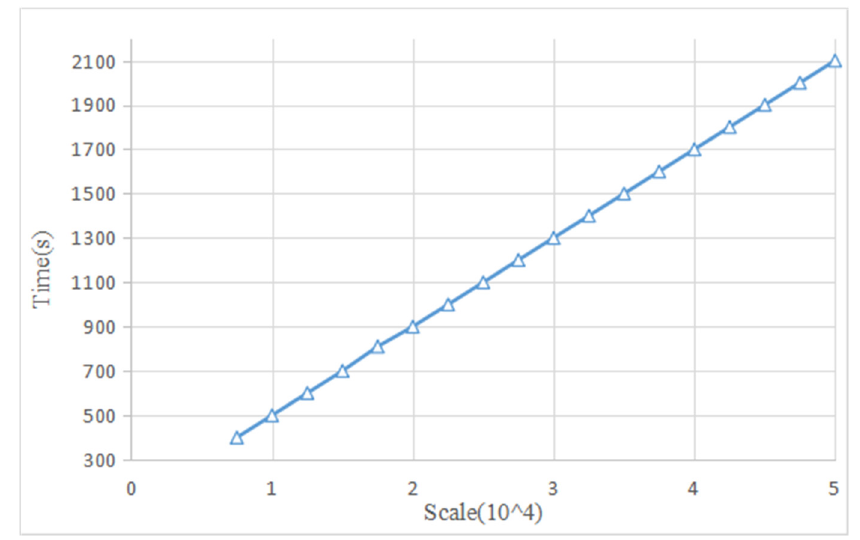
Figure 4. PSO-GA algorithm runtime test on a manually generated